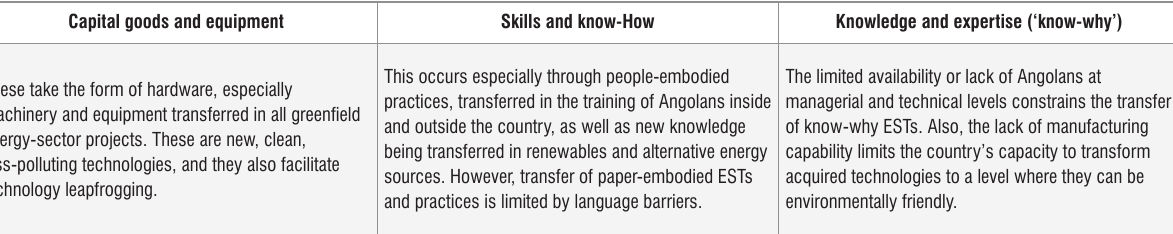
Types of environmentally sound technologies transferred through inward foreign direct investment to Angola’s energy sector Capital goods and equipment Skills and